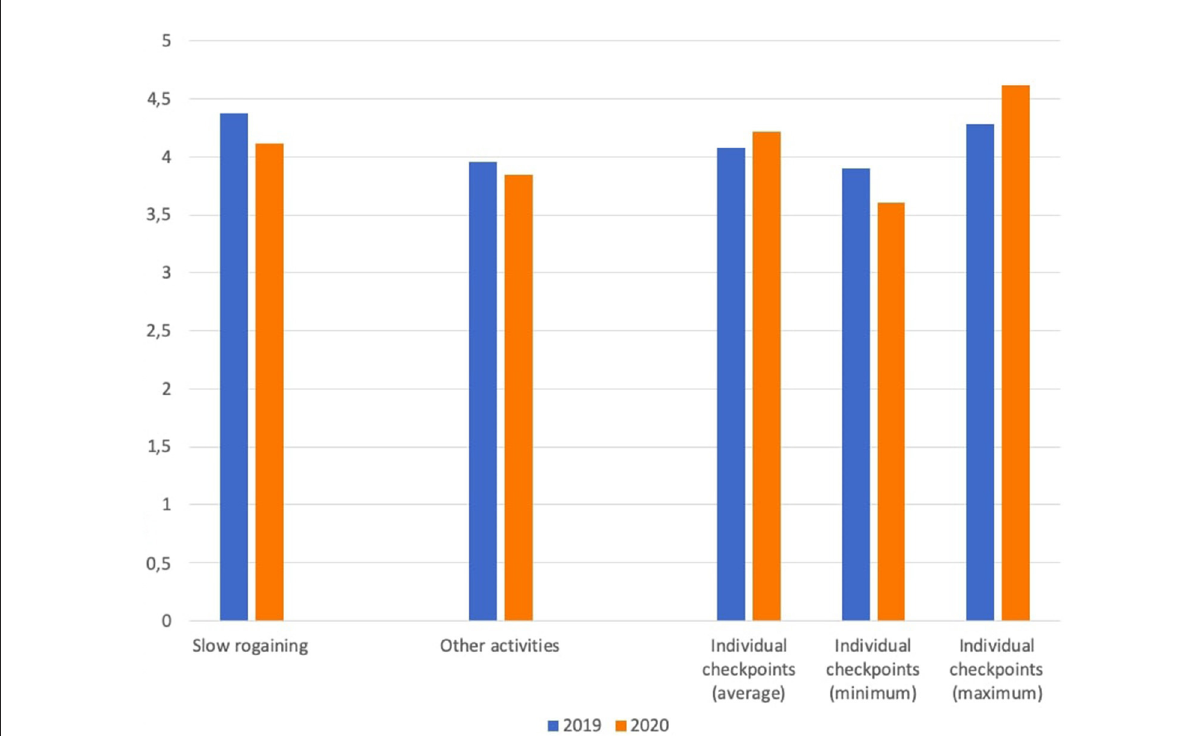
FIGURE8 Student appreciation for the internship activities and individual checkpoints in the two